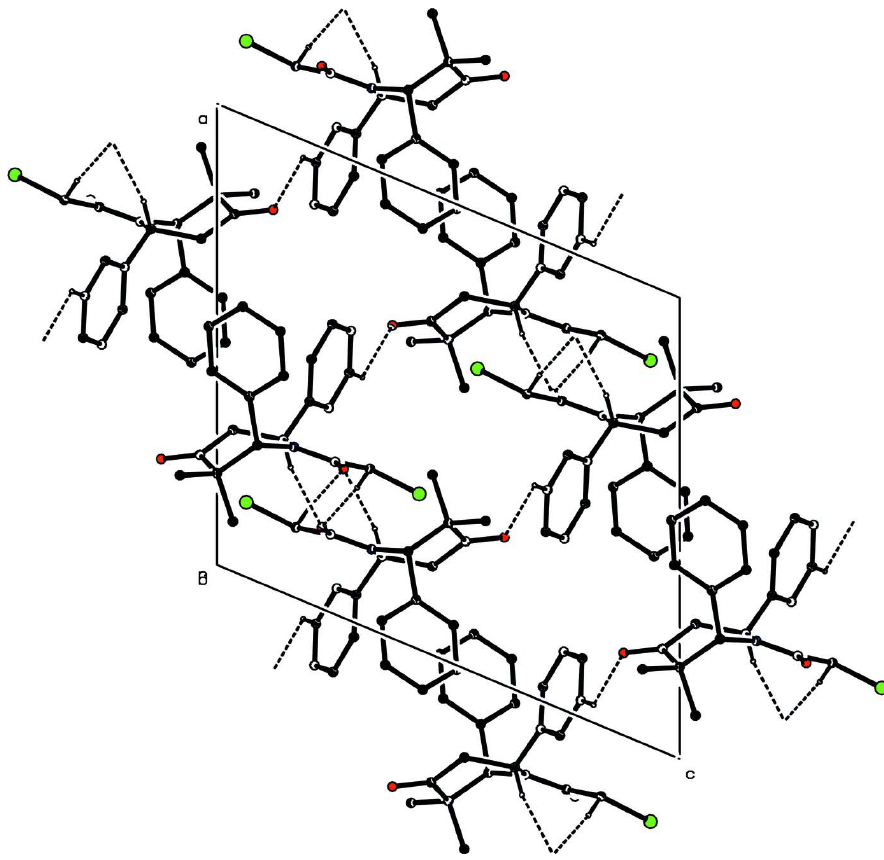
The crystal packing of the title compound, viewed along the b axis. Dashed lines indicate hydrogen bonds. H atoms not involed in hydrogen bonding have been